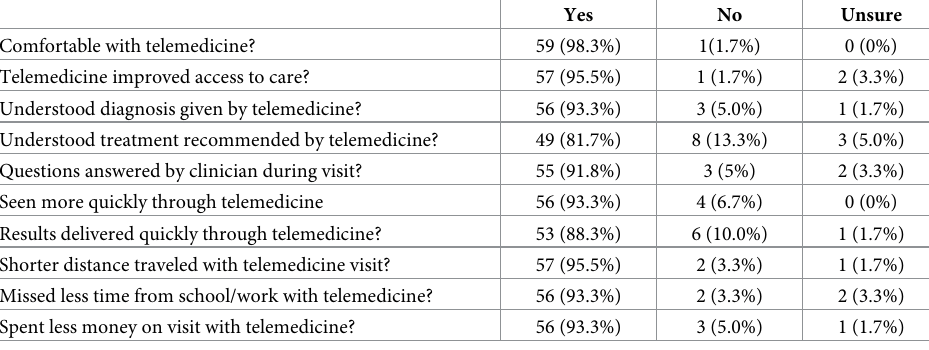
Table 3. Attitudes about telemedicine consultation.